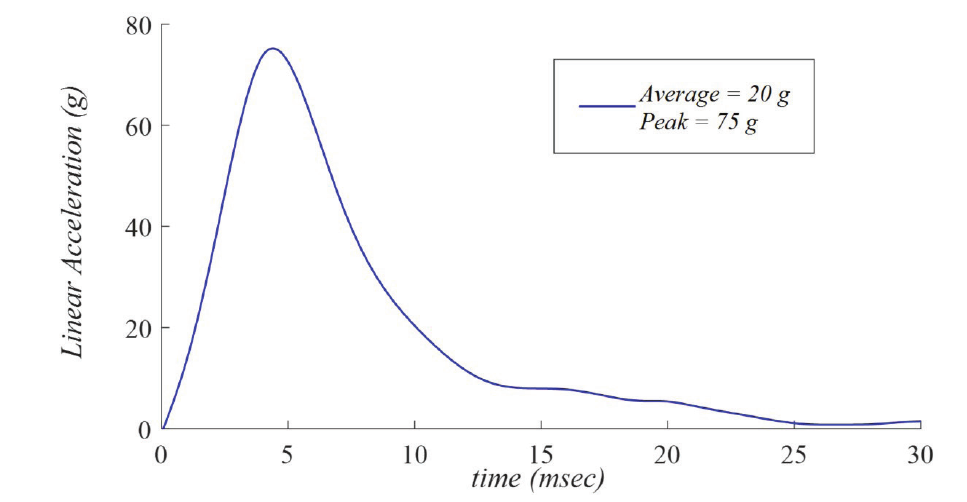
FIGURE 1. Head Linear Acceleration vs Time. G= 9.8 m/s²